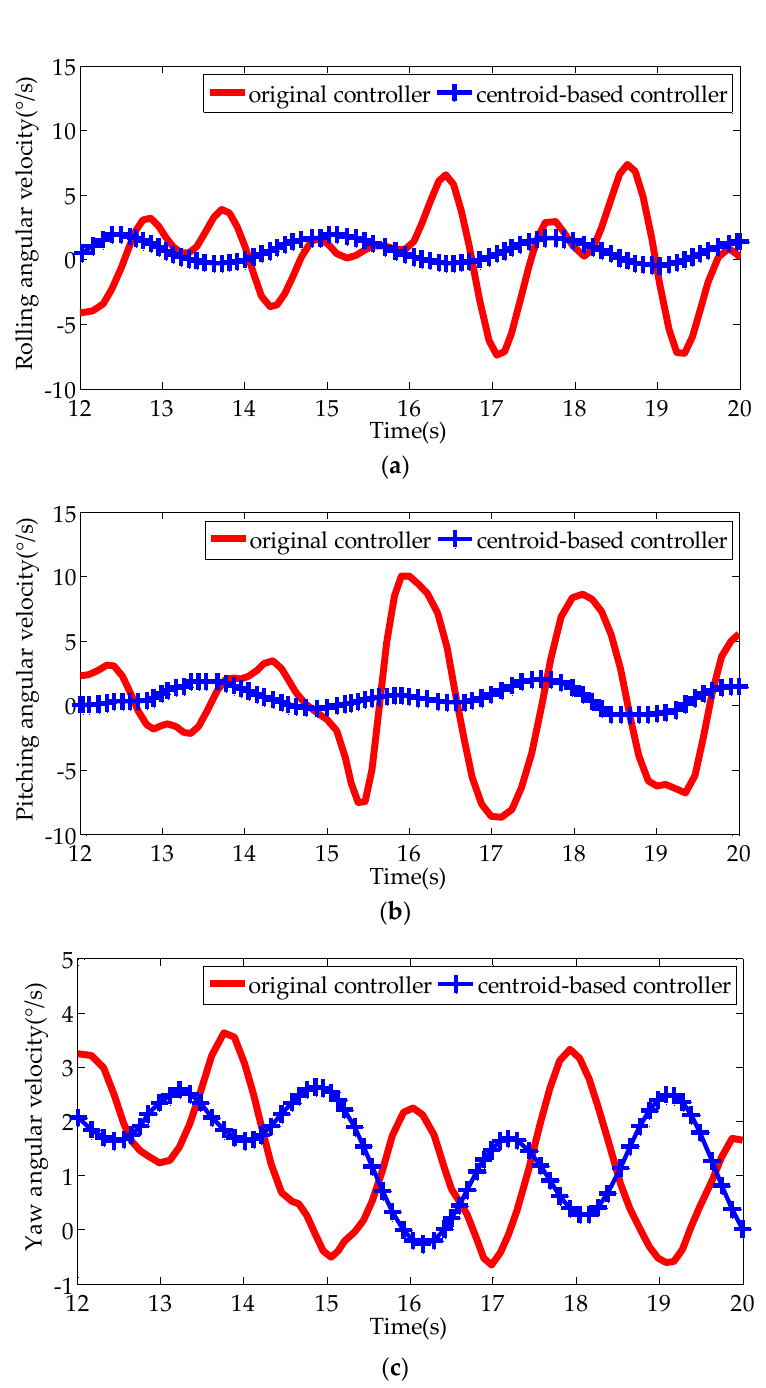
Figure 13. Angular velocity curves of robot trunk. ( a ) Rolling angle. ( b ) Pitching angle. ( c ) Yaw angle.